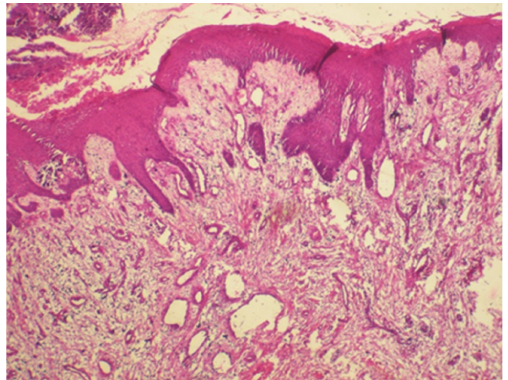
Figure 2: Photomicrograph showing stratified squamous epithe- lium overlying myxoid connective stroma with prominent vascula- ture (hematoxylin and eosin stain, 4x).